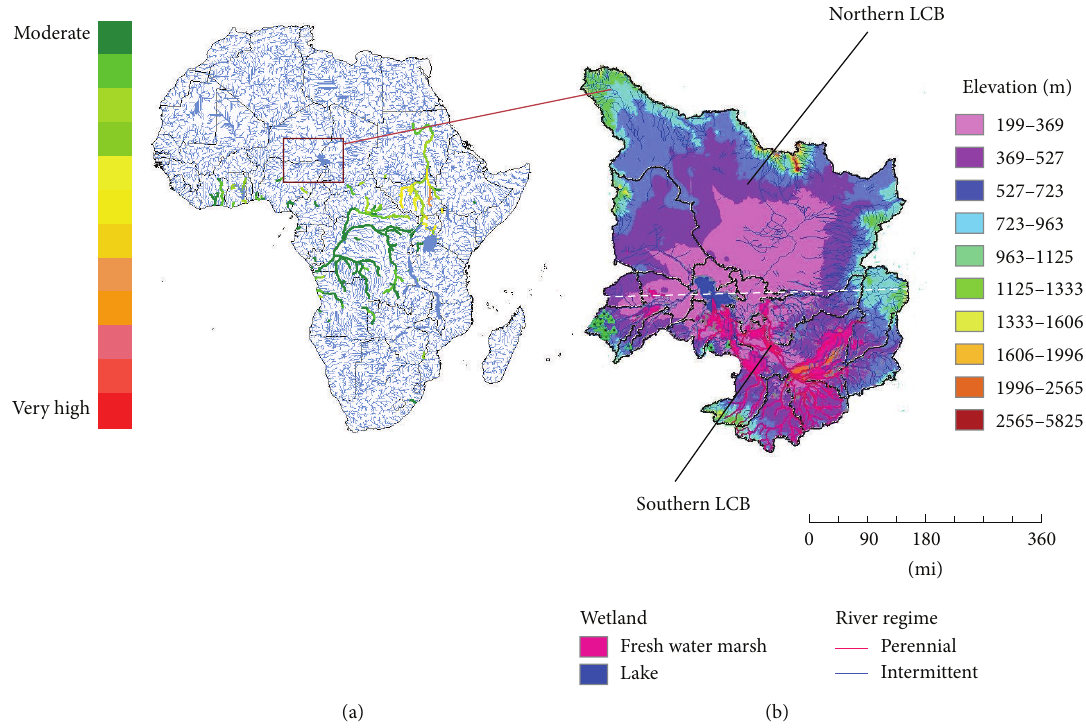
Figure 3: Study area. (a) River basin catchment map of Africa showing the Lake Chad Basin area (square), major rivers (blue), and runoff on October 12, 2012 (green-red); (b) LCB showing the major tributaries, the elevation, and the southern and northern parts of the lake (see text for